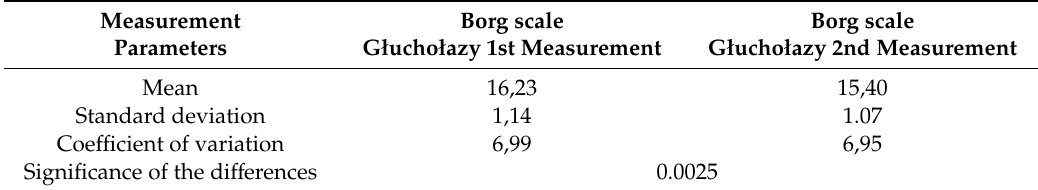
Table 6. Assessment of the subjective level of fatigue of the tested individuals in the 6MWT for the first and second study in Głuchołazy.